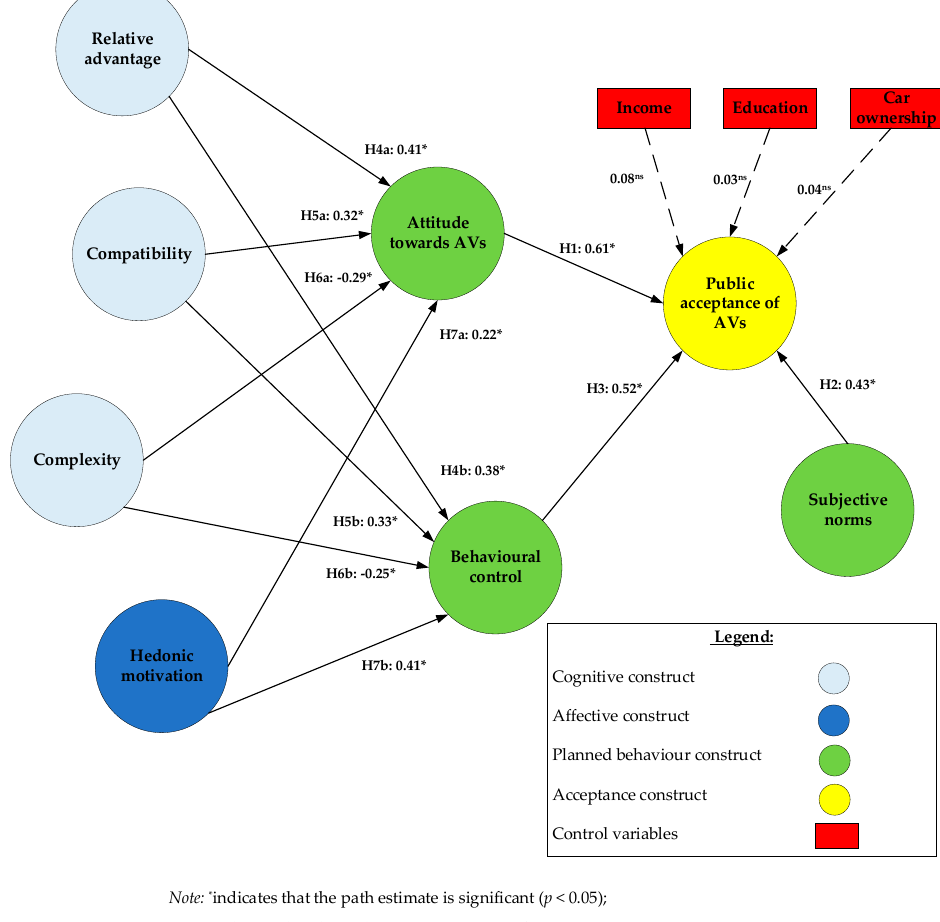
Figure 2. Parameter estimation of the proposed model.